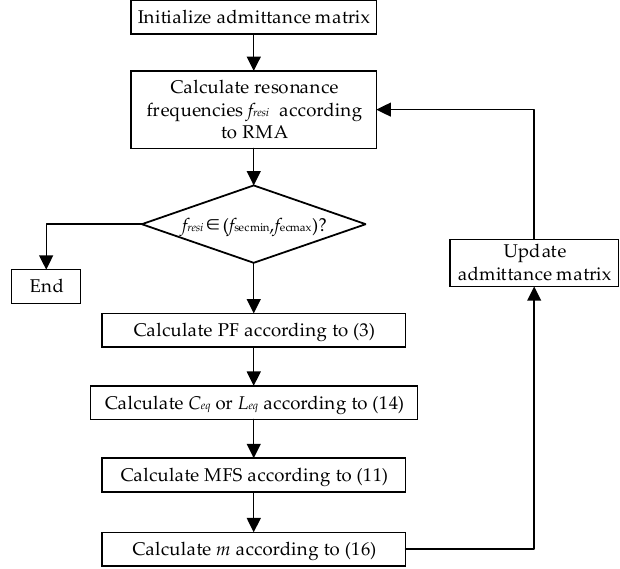
Figure 11. Flow chart of the optimization for grid-connected inverters.